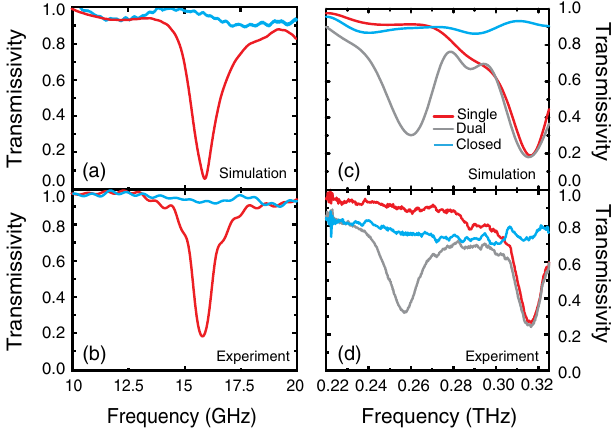
FIG. 4. Simulated (a) and (c) and experimental (b) and (d) results of MMs on the PGL. Panels (a) and (b) are for the single-pair GHZ-PGL case, with the red and blue curves corre- sponding to the cases of the open-gap and closed-gap resonators, respectively. Panels (c) and (d) show the data for the dual-pair THz-PGL case, plotted as the gray curves and in comparison with the cases of single-pair open-gap (red) and closed-gap (blue) resonators in the THz regime.